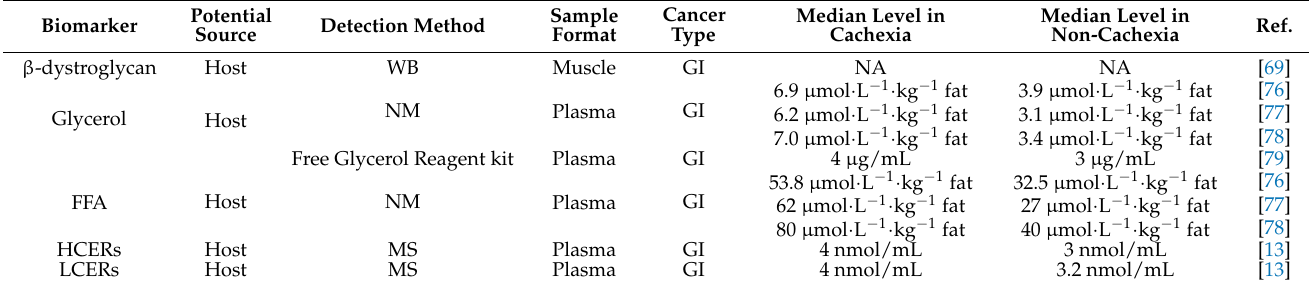
Table 3. Summary of muscle and fat wasting products as potential biomarkers of cancer